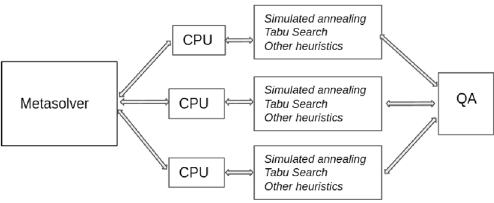
Figure 1. A functional diagram of the D-Wave Systems hybrid solver. The Metasolver on the left governs the overarching algorithm. It launches multiple threads which uses classical heuristic algorithms running on CPUs or GPUs as depicted in the middle of the figure. Simultaneously, it uses the quantum annealer (QA) on the right to search for promising solutions of smaller subsets of the problem to provide additional promising starting points to the heuristic